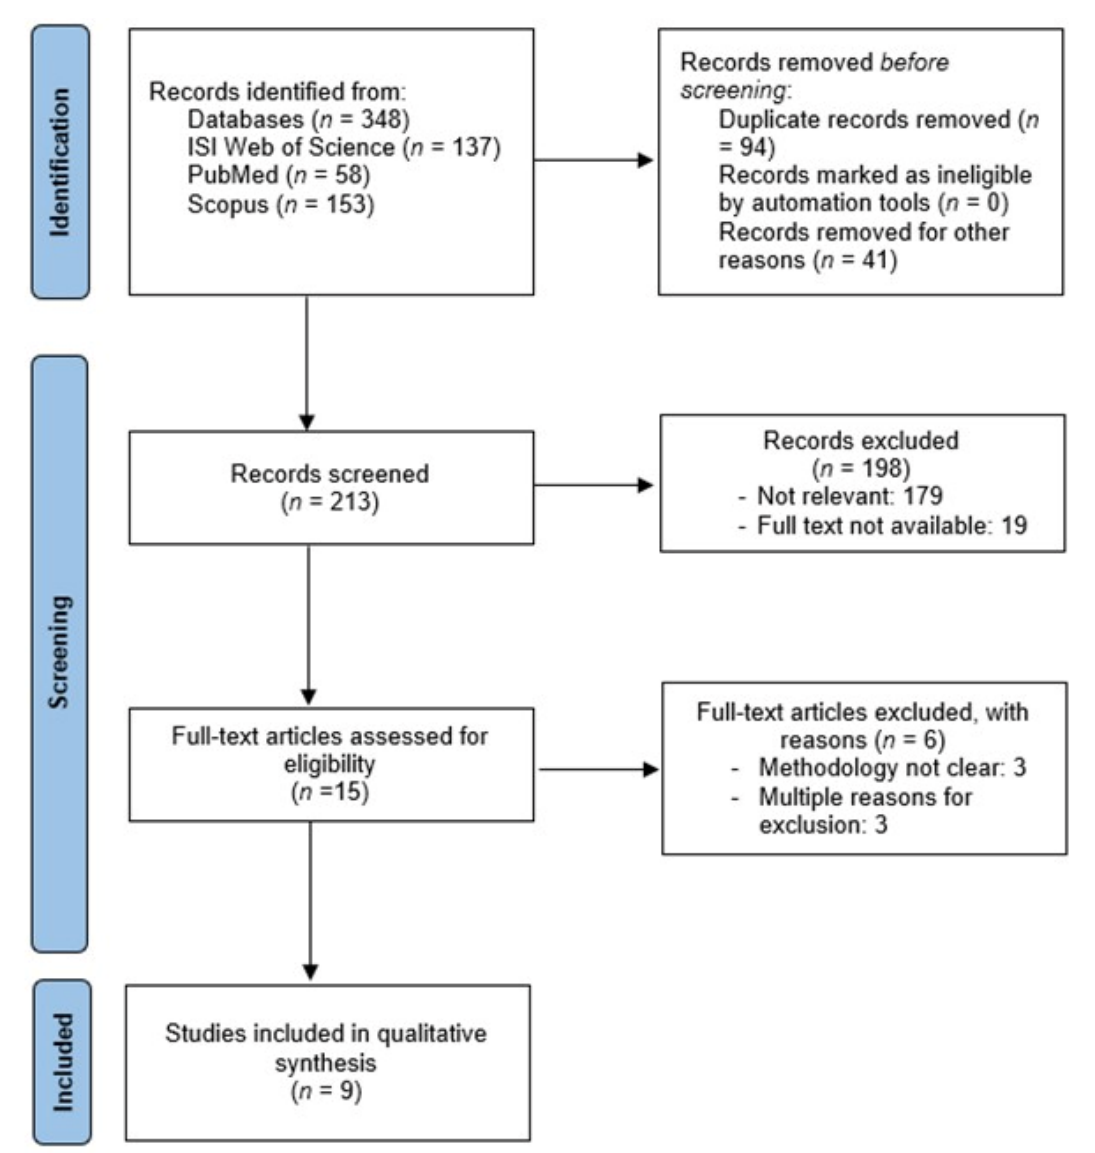
Figure 1. PRISMA study fl ow